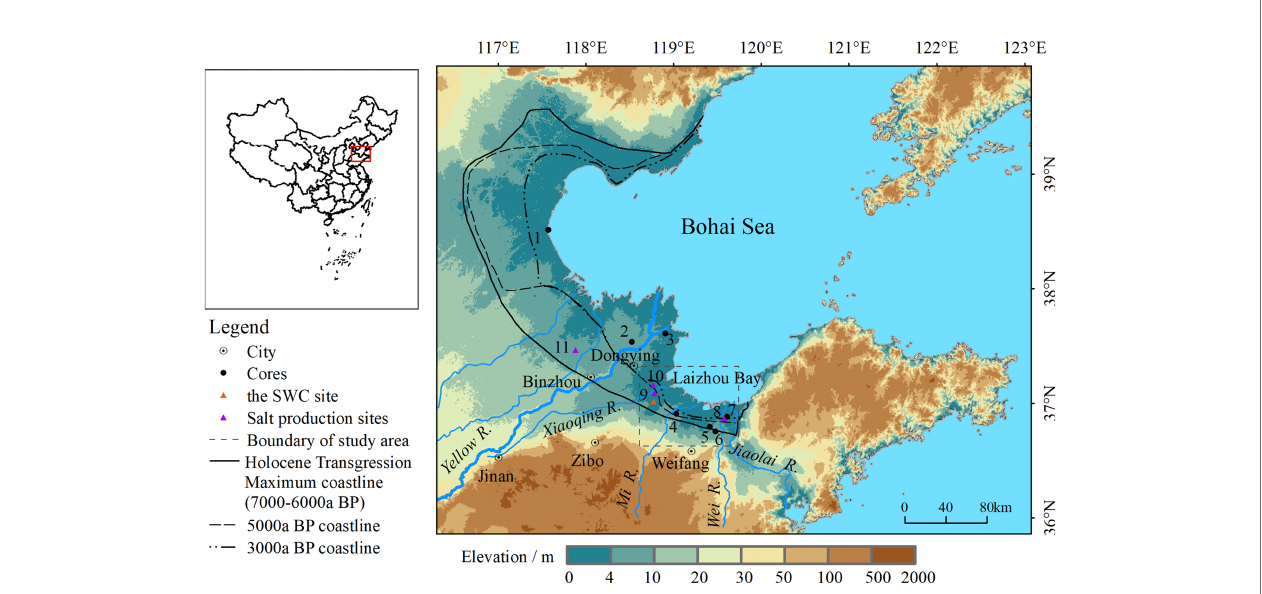
FIGURE 1 | Topographical map and the location of the SWC site, the cores,the excavated salt production sites and coastlines of different period. (1. the BQ1 core, 2. the H9601 core, 3. the H9602 core, 4. the ZK305 core, 5. the A5 core; 6. the A1 core, 7. the ZK303 core, 8. the Huodao-aoli site, 9. the Dahuangbeiyang site, 10. the Nanheya site, 11. the Liwu